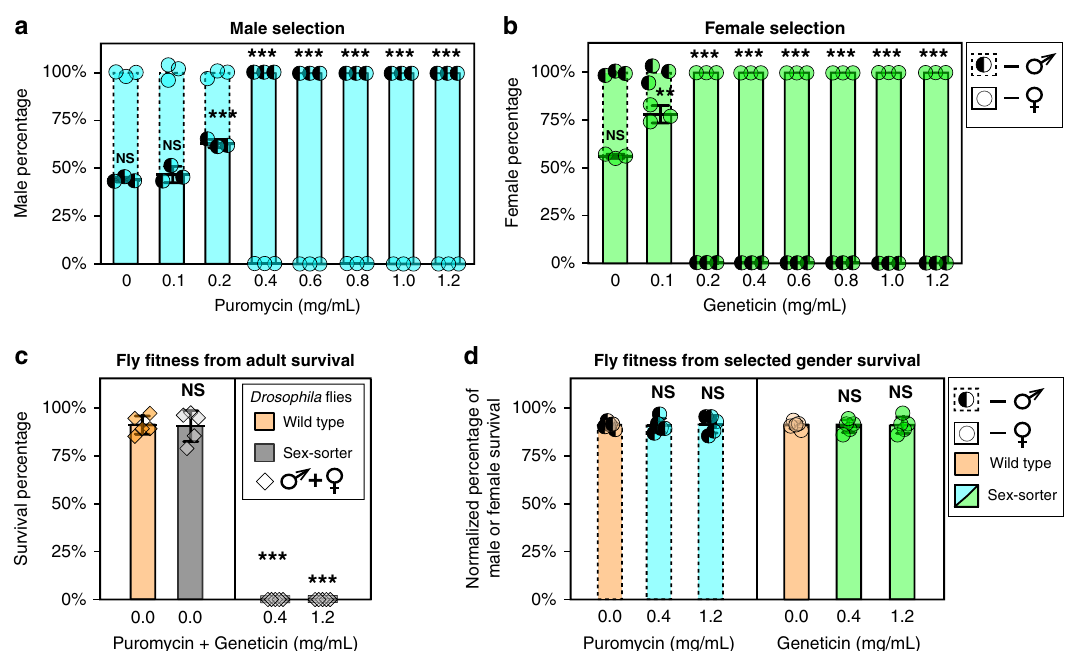
Fig. 3 Sex selection and fi tness of fl ies carrying two copies of sex-sorter cassette. The sex-sorter cassette includes NeoR traF and PuroR dsxM genes that confer resistance to the antibiotics puromycin and geneticin, respectively, in a sex-speci fi c manner (Fig. 2a). The PuroR dsxM gene is properly spliced, which results in the expression of the functional PuroR protein only in males, while NeoR traF expresses the functional NeoR protein only in females. To estimate the lowest concentration of an antibiotic at which male or female selection is enforced at 100%, the homozygous sex-sorter fl ies were raised on various concentrations of puromycin or geneticin. a Only male fl ies emerged from the food supplemented with 0.4 mg/mL or more of puromycin. b Raising the same fl ies on food containing 0.2 mg/ml or more of geneticin resulted in the emergence of only female fl ies. To compare the fi tness of homozygous sex- sorter fl ies to that of wildtype (wt) fl ies, the embryo-to-adult survival of both fl y types were compared under normal and selective conditions. c Embryos of both sex-sorter (gray bars) and wt fl ies (white bars) survived to the adulthood equally well on food without any antibiotics and died on the food supplemented with both puromycin and geneticin at concentrations of 0.4 and 1.2 mg/ml. d The survival of male or female sex-sorter fl ies under selection treatments was statistically identical to that of the corresponding sex from wt fl ies raised under normal conditions. Bar plots show the average ± one standard deviation (s.d.) over at least three biological replicates. Statistical signi fi cance was estimated using a t test with equal variance. ( ns P ≥ 0.05 , * P < 0.05, ** P < 0.01, and *** P < 0.001). Source data available in Supplementary Data 1 –